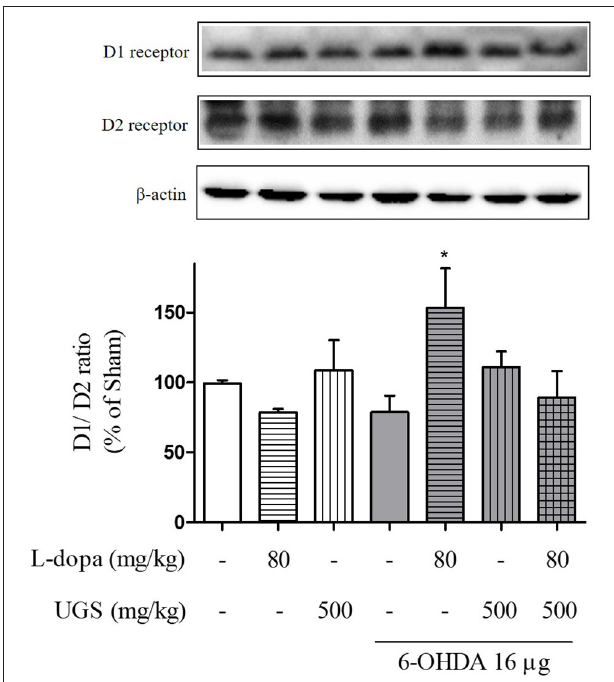
FIGURE 4 | UGS regulated the L-dopa-induced alterations in the expression of dopamine receptors in 6-OHDA-injected mouse ST . Representative band image of the expression of dopamine receptors from western blot analysis, quantification data of D1R and D2R. The D1R/D2R ratio was evaluated. Values of quantification data are given as the mean ± S.E.M. ( N = 6). The significance of differences was analyzed by one-way ANOVA followed by Bonferroni’s Multiple Comparison Test: * p < 0.05; mean values were significantly different from the 6-OHDA